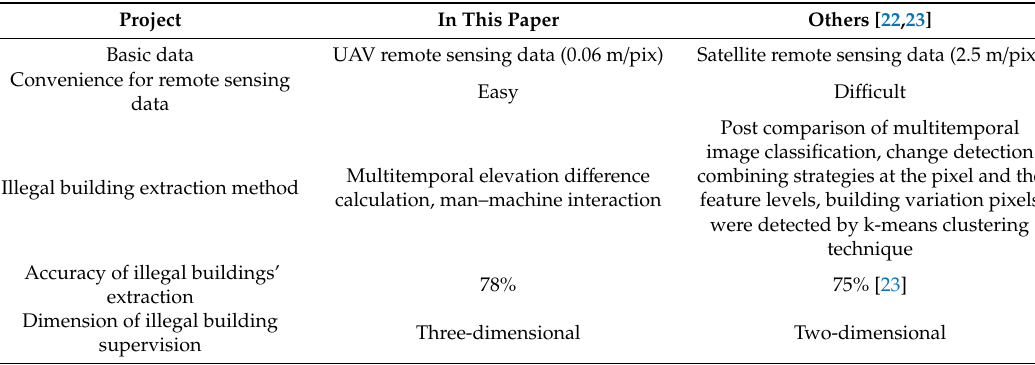
Table 1. Comparison table of illegal buildings’ identification and monitoring research. UAV: